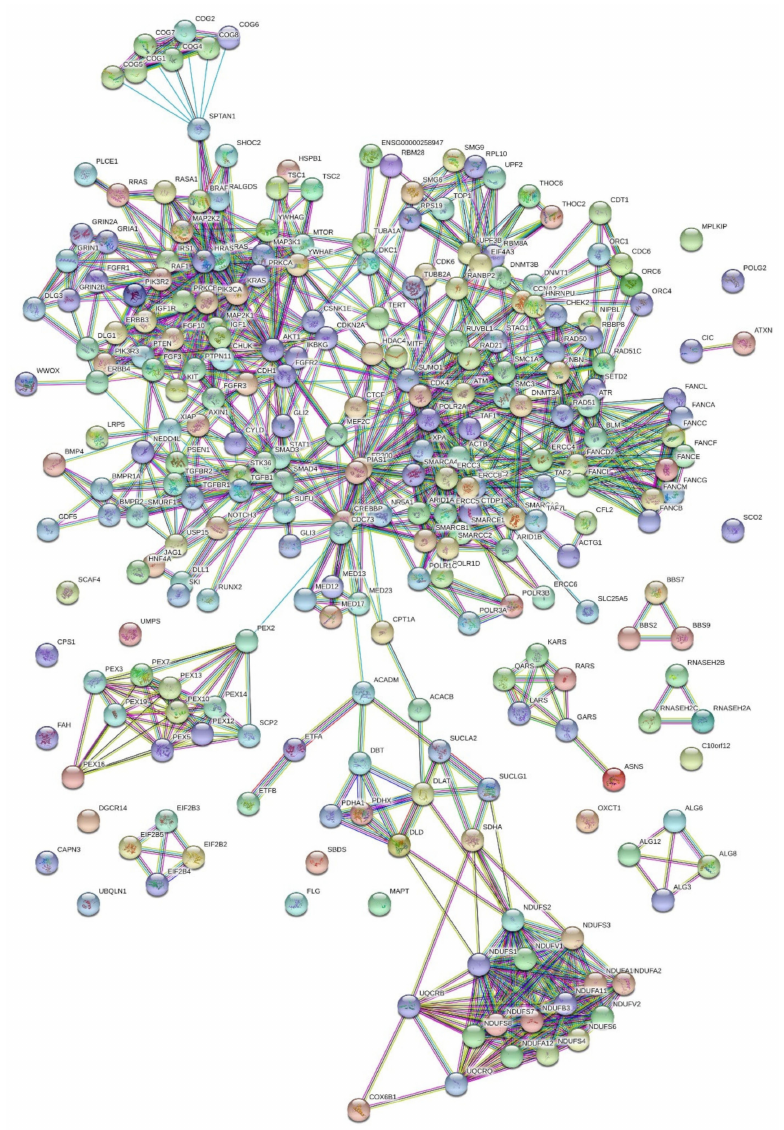
Figure 2. String Analysis of 659 genes at p = 0.001 : 659 genes were evaluated for their protein–protein interactions (at a confidence interval of 0.9), resulting in a subset of 273 genes which were further analyzed for their mRNA co-expression. The ensuing 121 genes (Pearson’s of 0.7). were mapped for their antenatal/postnatal expression in Research Domain Criteria (RDoC)-defined neural circuits using Brodmann